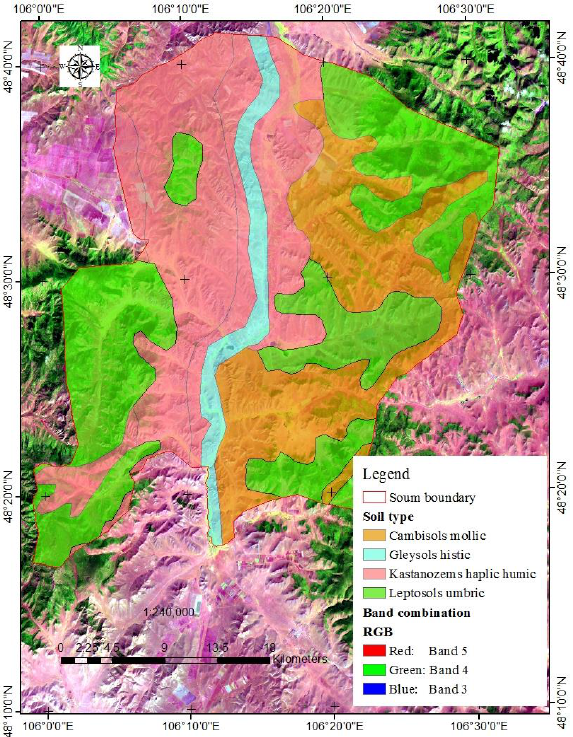
Figure 2. Color composite image from Landsat +ETM bands which are 5, 4 and 3 and thematic soil map (source: Institute of Geography, Mongolian Academy of